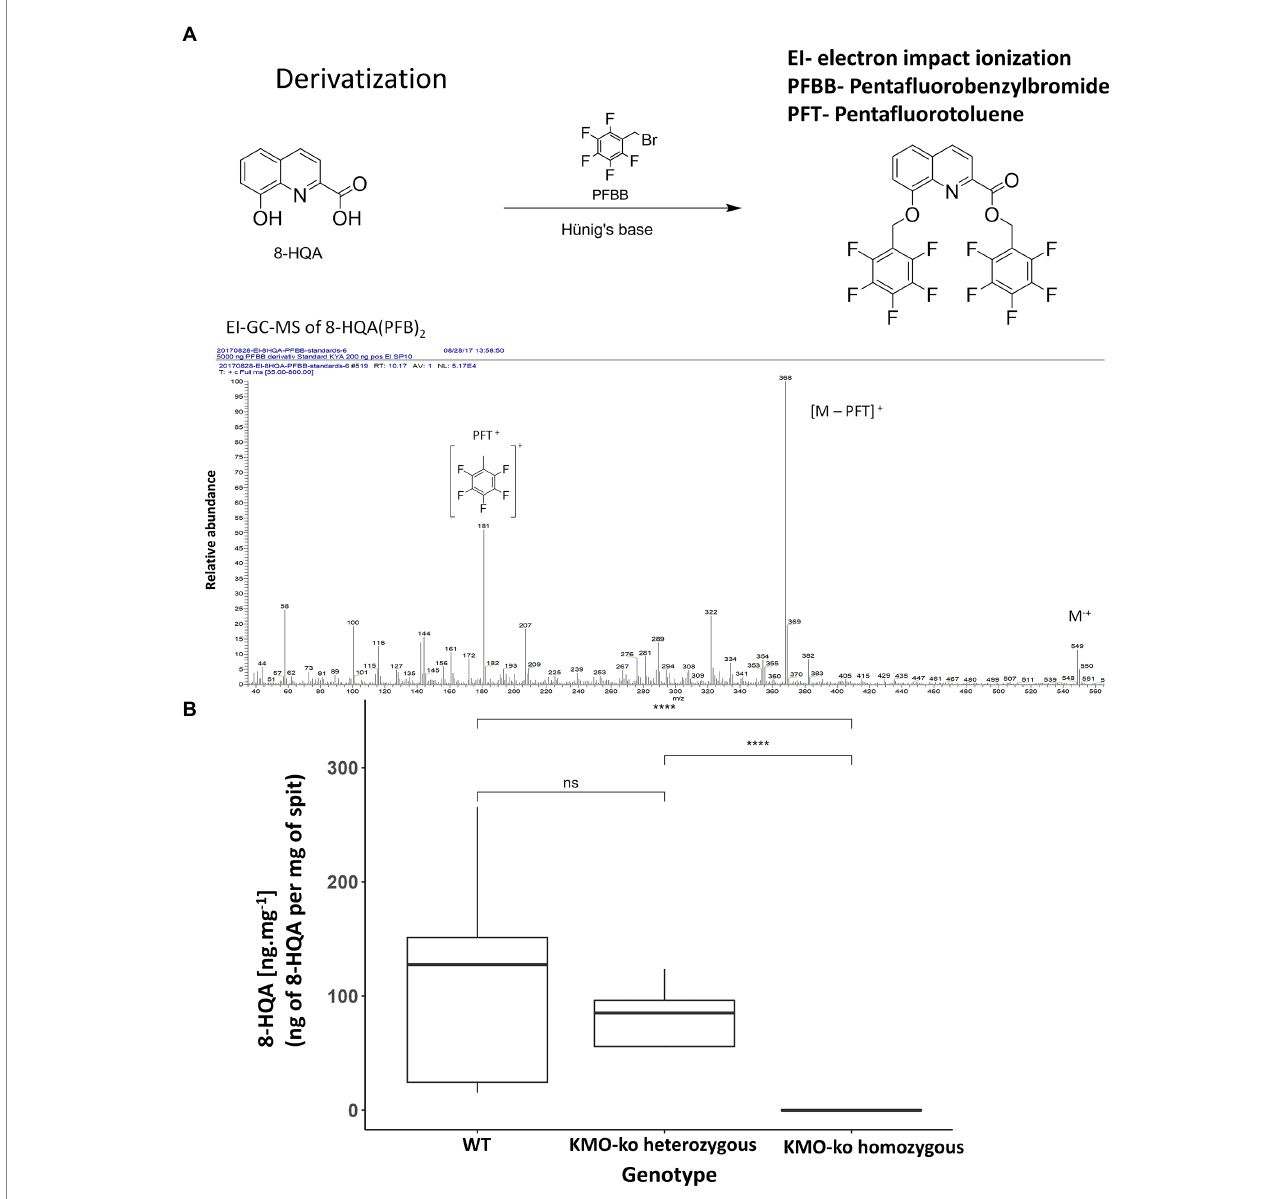
FIGURE 3 Detection and quantification of 8-HQA. (A) Derivatization of 8-HQA with PFBB and mass spectrum of the derivatized compound. (B) Concentration of 8-HQA in μ g ml − 1 of regurgitant of the larvae in 5th instar wildtype (WT) and KMO gene knockout larvae. On the average, a WT larva has 142 μ g ml − 1 of 8-HQA in the regurgitant (Wilcoxon test, p < 0.05).